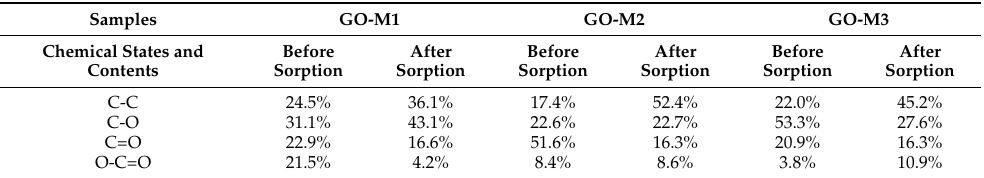
Table 4. Chemical states and contents of carbon on the surface of three types of GOs before and after the adsorption of